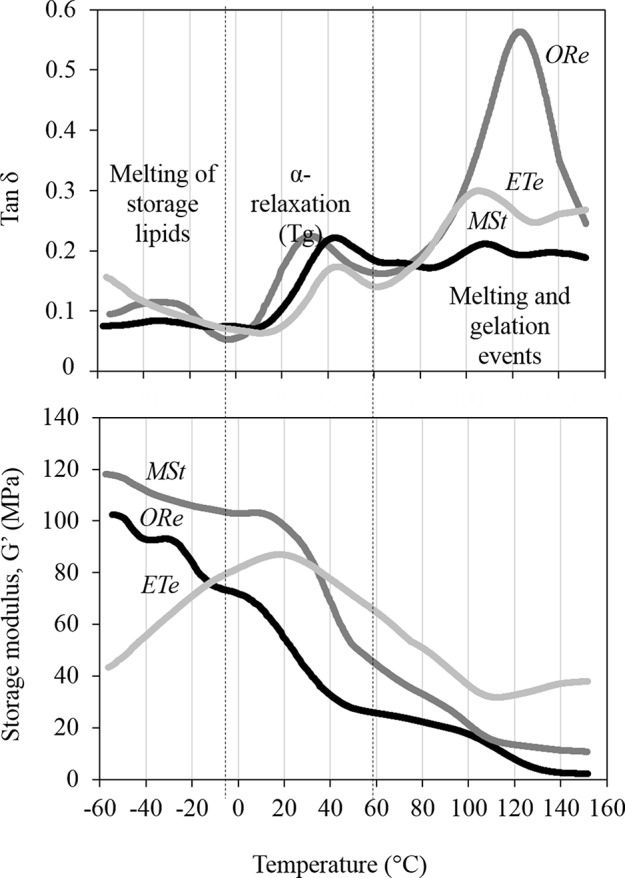
Dynamic mechanical thermal analysis (DMTA) scans of ORe, MSt, and ETe CS desiccated at 10% RH for 48 h. α-Relaxation is characterized by a peak in the tan δ between 30 and 50°C (upper panel) that coincides with a large decrease in storage modulus (G’) (lower panel). α-Relaxation coincides in temperature with the glass transition temperature (Tg) measured by differential scanning calorimetry (Ballesteros et al., 2017). Other molecular relaxations are observed above and below the Tg that are associated to melting and gelation events (as from Ballesteros and Walters, 2011) and melting of the storage lipids (Ballesteros et al., 2017), respectively. One representative curve (from n = 3 independent biological replicates) is shown for each spore species.